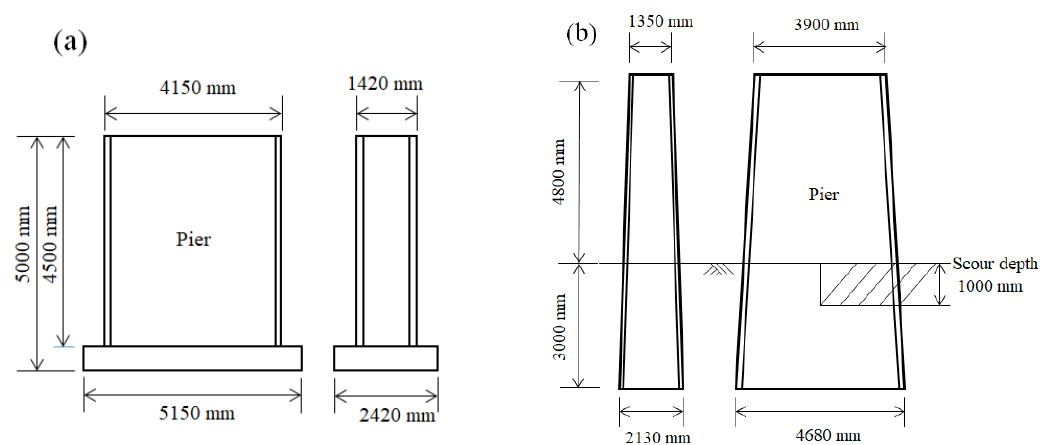
Figure 1. Schematic view of the pier: ( a ) full-scale model pier and ( b ) field bridge pier.